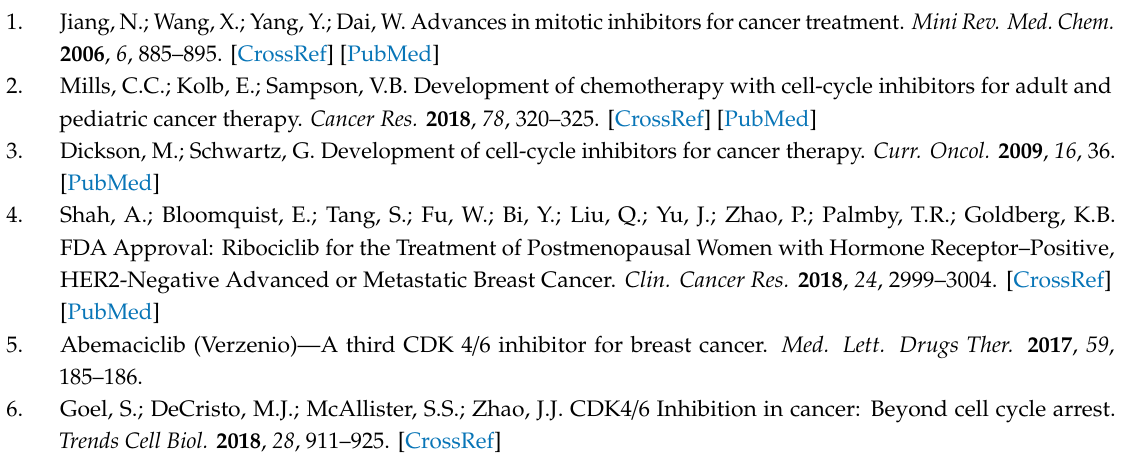
Figure S1: Immunofluorescence for HLA-G and PD-L1 protein expression, Figure S2: Explanatory figure for cell cycle analysis based on decile 2 (Figure 2), Figure S3: Images captured at 15 min after co-culture of BMNCs (Plain arrow; small round cells) with OVCAR-3 cells (Dotted Arrow; with stained Nuclei in blue), Figure S4: FACS overlay peaks for Isotype and specific staining, Video S1: OVCAR-3 cell were co-cultured with BMNCs as explained in materials and